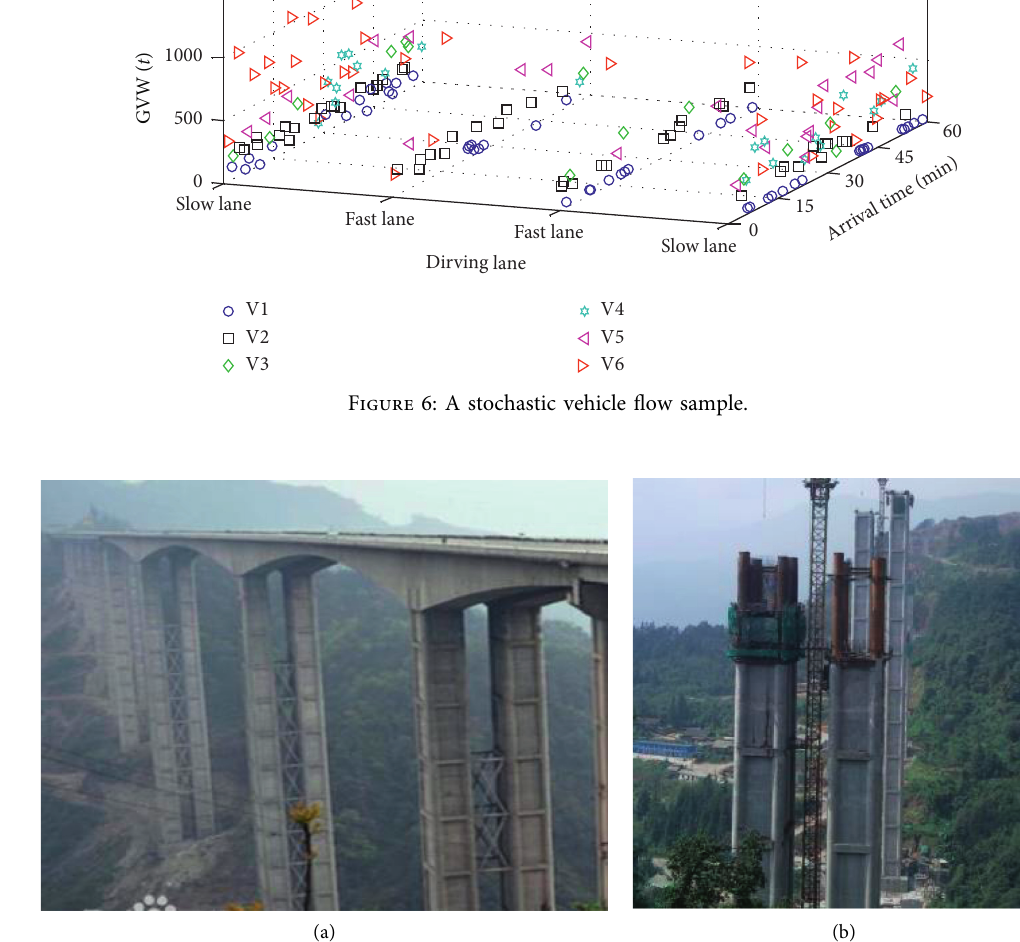
Figure 7: In-site photos of the Labajin bridge in Yalu highway: (a) final state; (b) construction